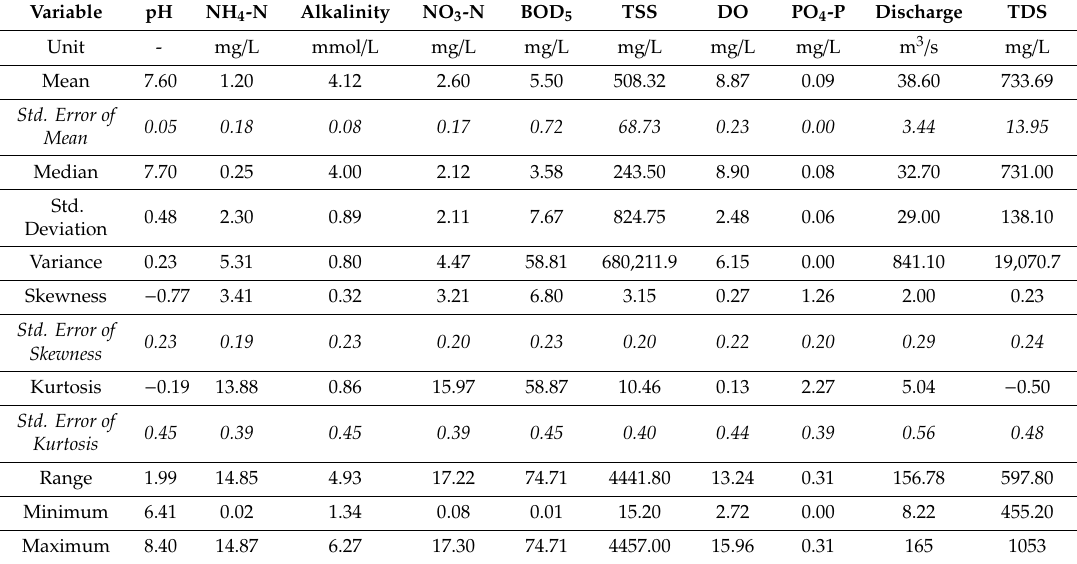
Table 2. Statistical indicators of the hydrological parameters recorded in the control section of Tandarei from the Ialomita River Basin (2007–2016); TSS—total suspended solids, DO—dissolved oxygen, and TDS—total dissolved salts.